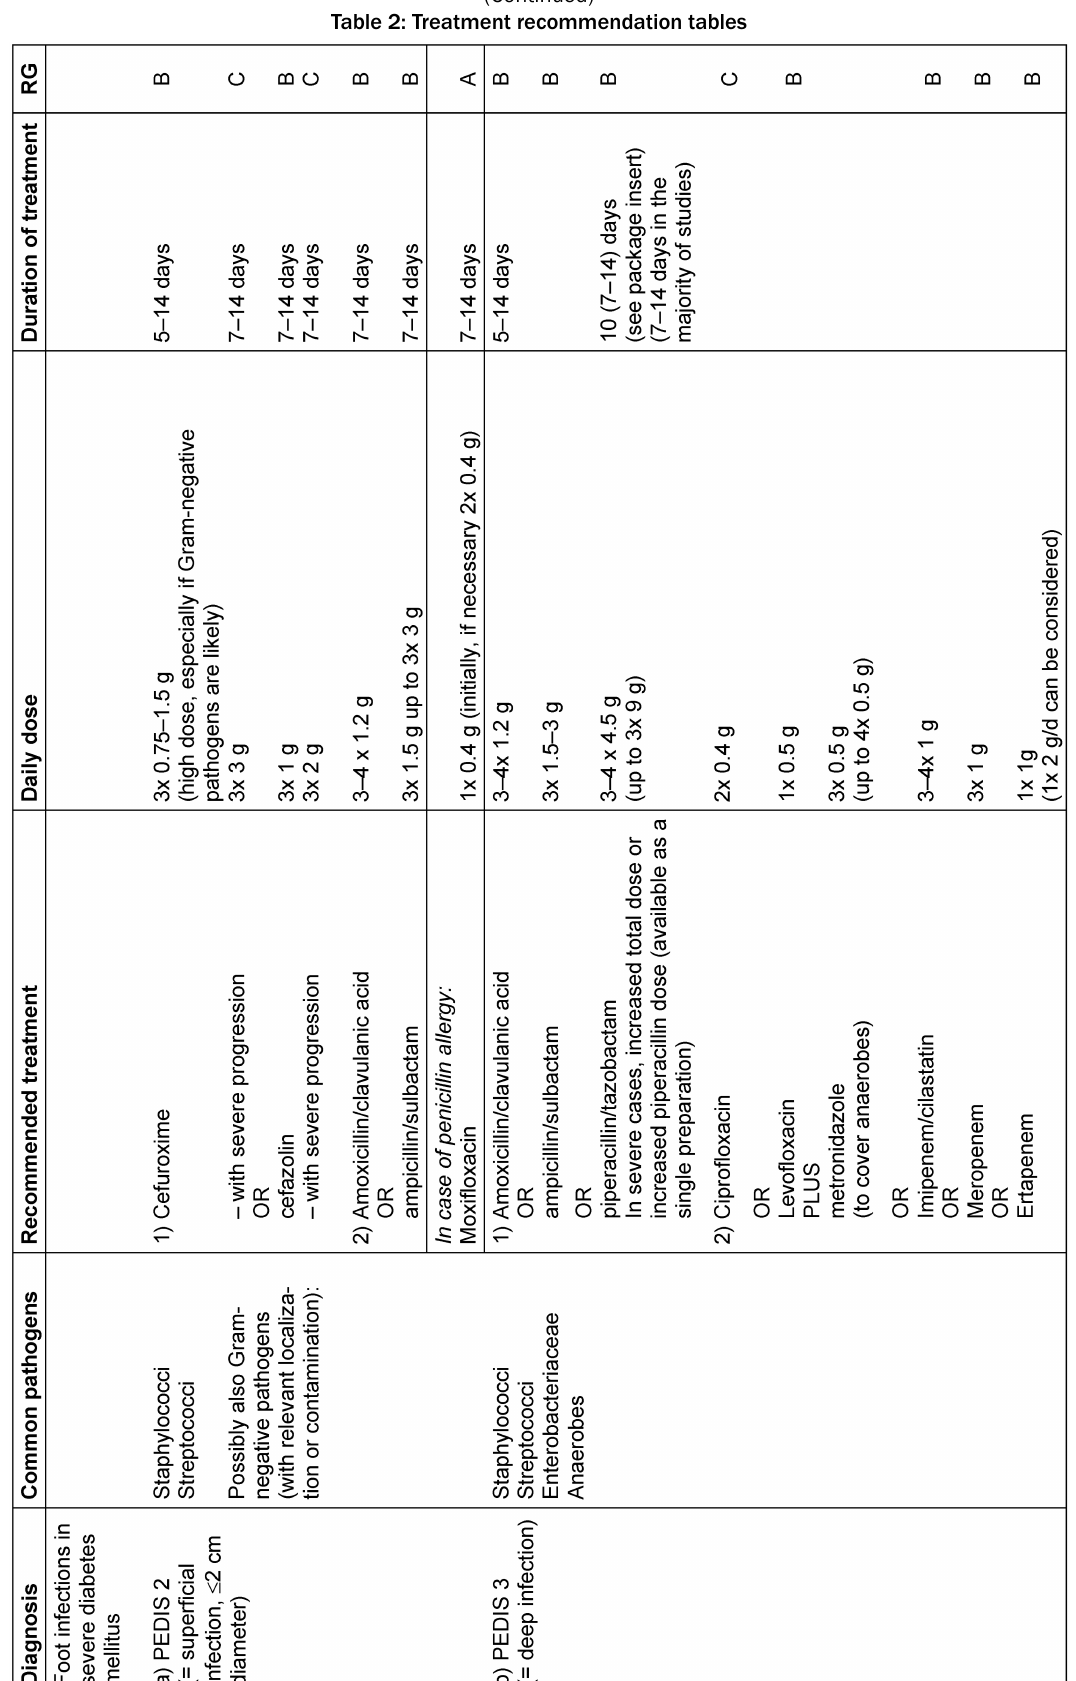
Table 2: Treatment recommendation